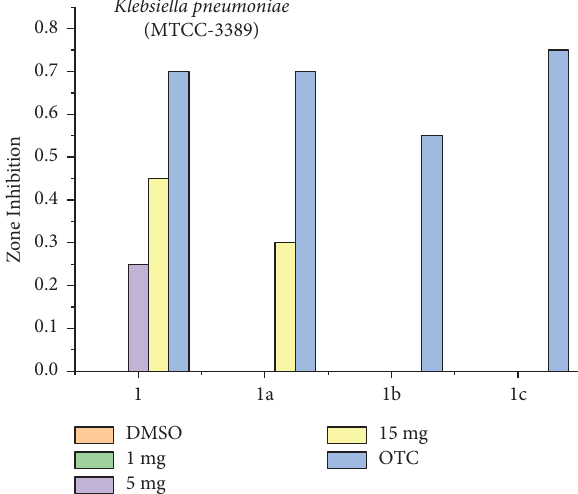
Figure 5: Radius of the zone of inhibition (mm) against K. pneumoniae (MTCC-3389) in the range of 1–15mg/mL sample ( 1 , 1a , 1b , and 1c ) with positive control of 50mg/mL oxytetracycline.